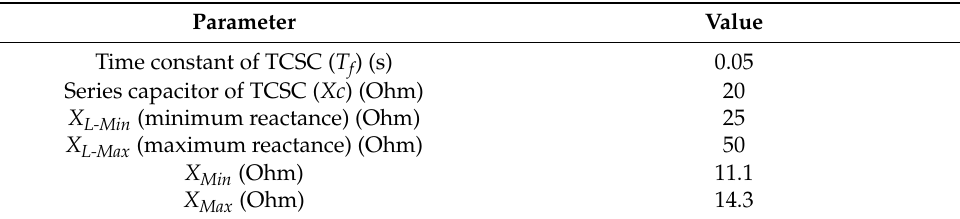
Table 7. TCSC parameters.